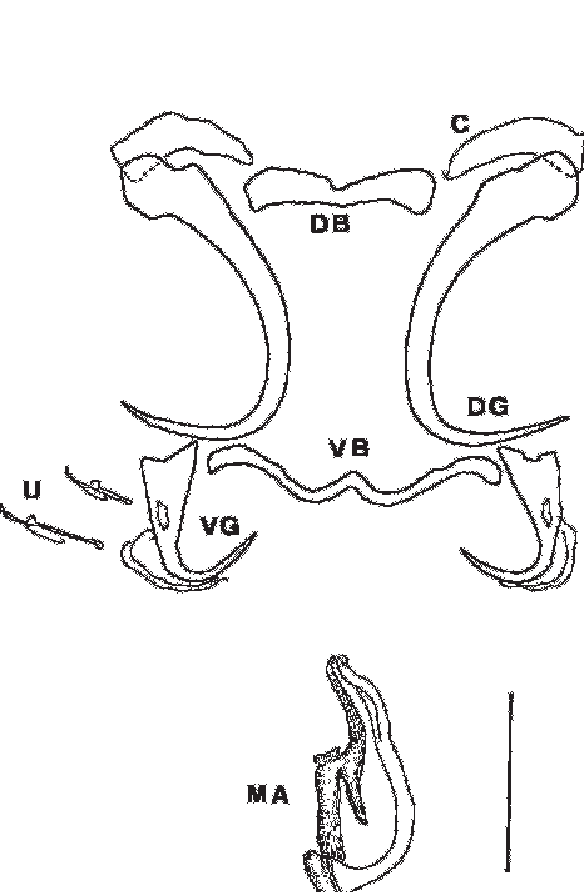
Fig. 2. – Thaparocleidus pouyaudi n. sp. C = cuneus; DB = dorsal transverse bar; DG = dorsal gripus; MA = male apparatus; VB = ven- tral transverse bar; VG = ventral gripus; U = uncinuli. Bar = 30